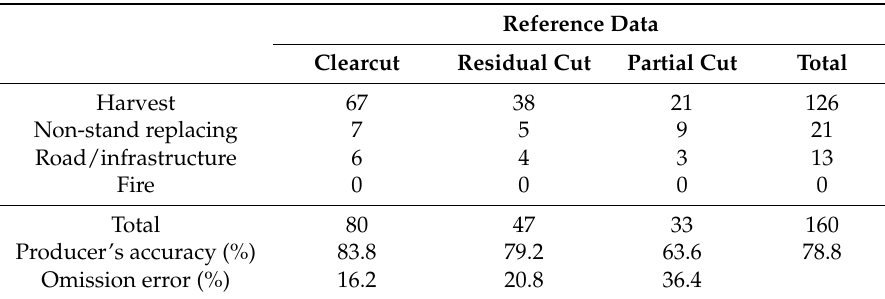
Table 2. Accuracy of C2C (Composite2Change) harvest attribution.